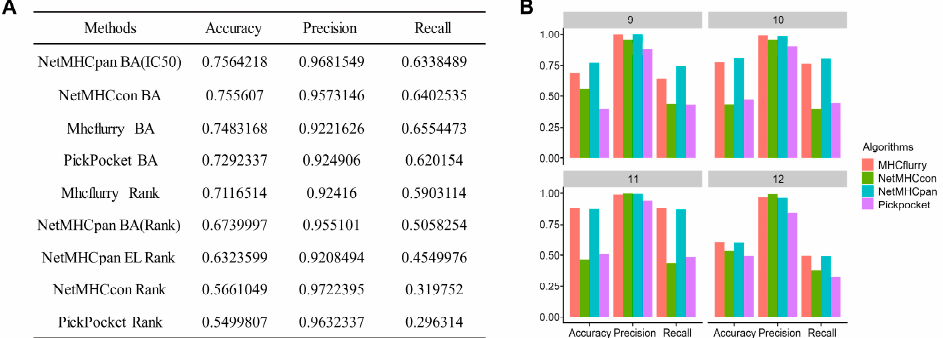
Figure 2. A benchmark analysis of different HLA-I binding affinity prediction algorithms: ( A ) a comparison of the performance of different algorithms in terms of prediction accuracy, precision and recall (the dataset was downloaded from IEDB and the thresholds of an IC50 value less than 500 nM and a rank percentile less than 1% were used to determine positive peptides); ( B ) a comparison of the different algorithms on different lengths of peptides.